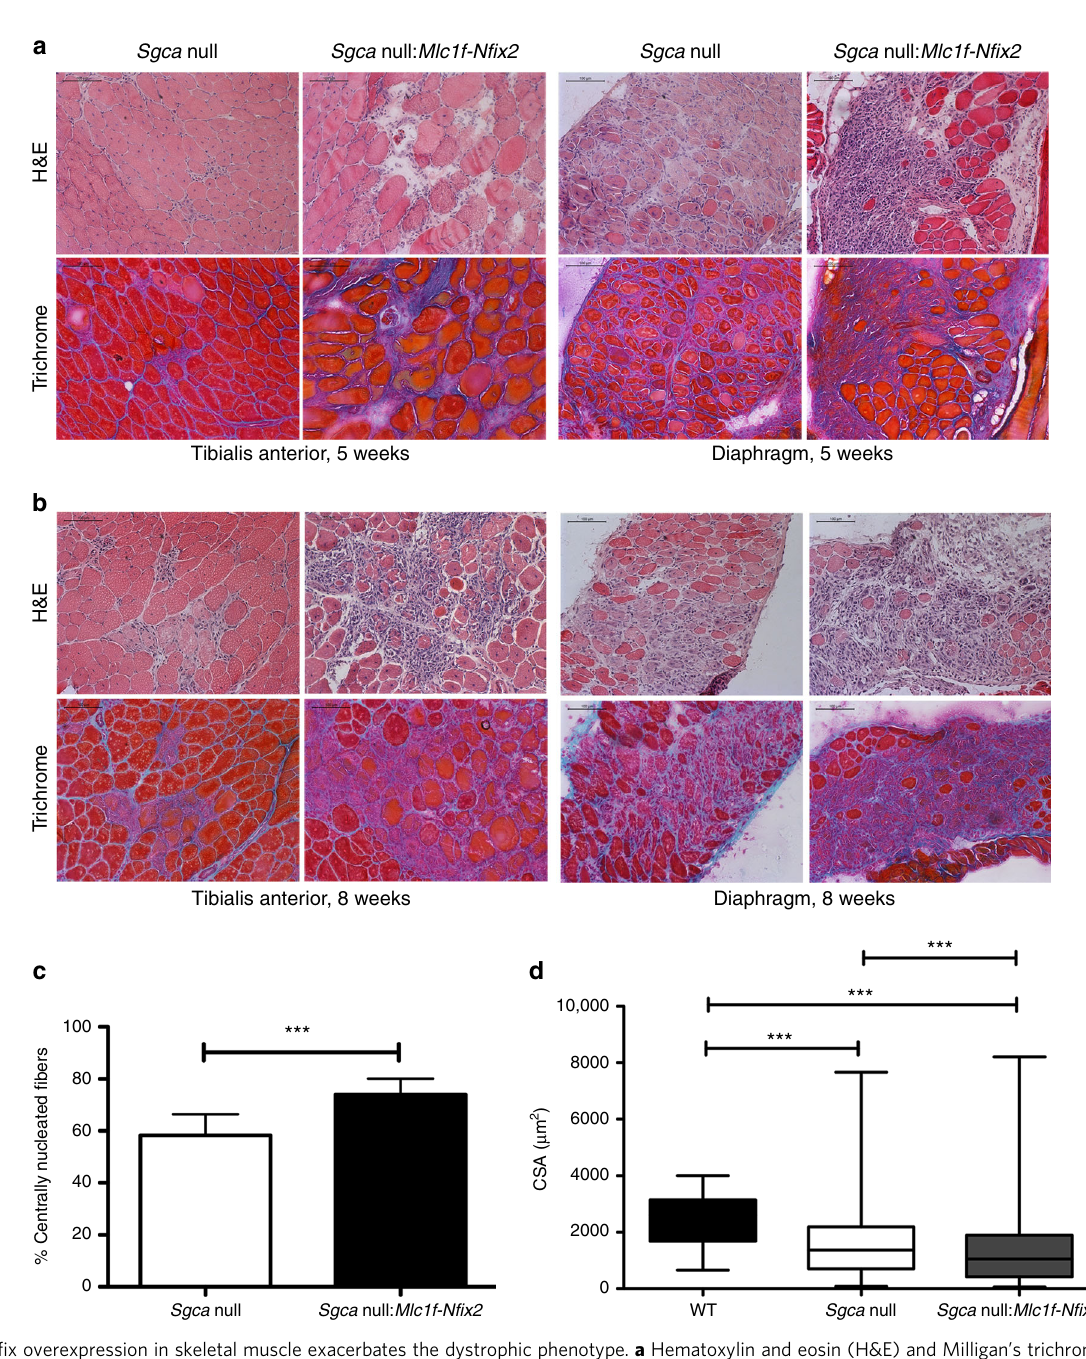
Supplementary Fig. 4 for PCR and WB analysis of N fi x expression in Sgca null: Mlc1f-N fi x2 mice, as well as for central nucleation and CSA